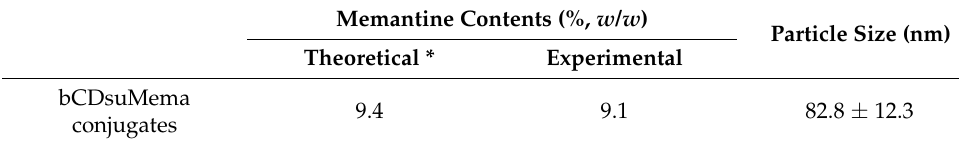
Table 1. Characterization of nanoparticles of bCDsuMema conjugates.